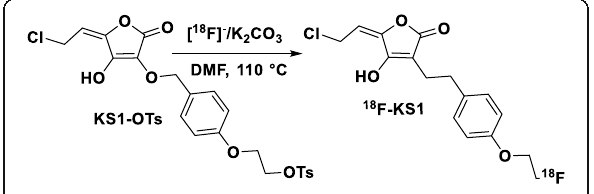
Fig. 3 Synthetic scheme of 18 F-KS1